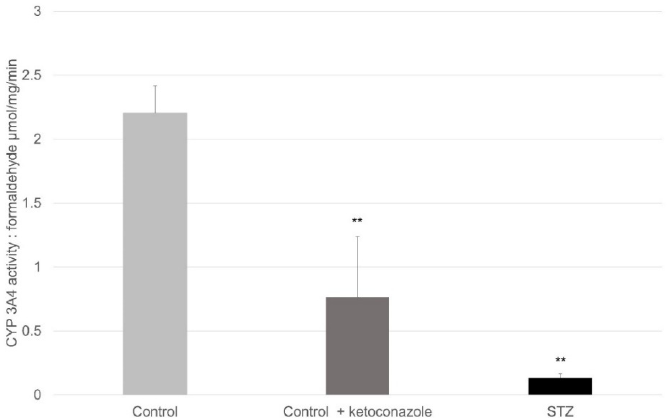
Figure 6. Activity of CYP 3A4 of the small intestine in control, positive control and diabetic rats. Values represent the mean ± S.E. of five rats. Each value represents the mean of 5 independent experiments ± standard error. **, p < 0.01 versus control. STZ, steptozotocin. The enzyme activity is expressed in µ mol formaldehyde/mg/min, which was conjugated in 1 min which was calculated for 1 mg protein of the small